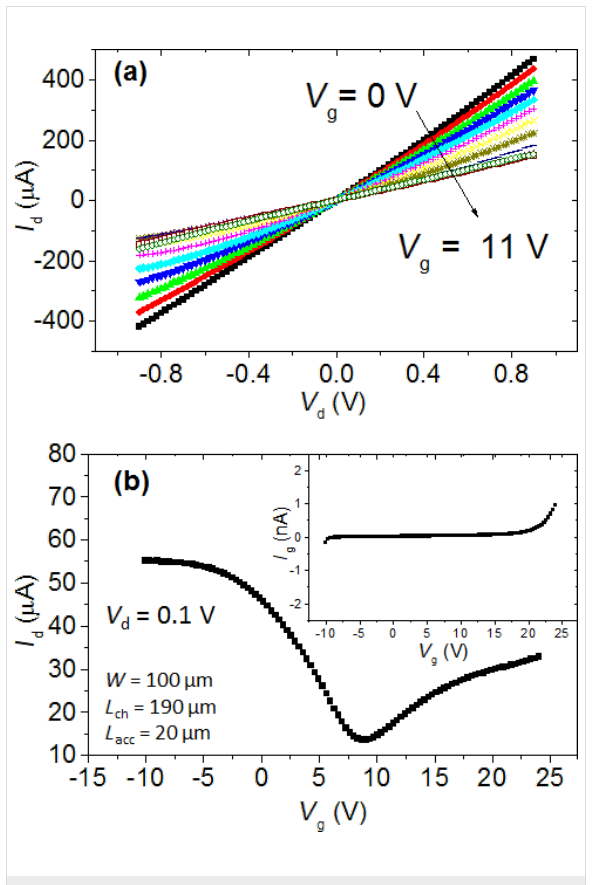
Figure 5: a) I d – V d characteristics at different back gate bias values and b) I d – V g transfer characteristic for a representative Gr-FET